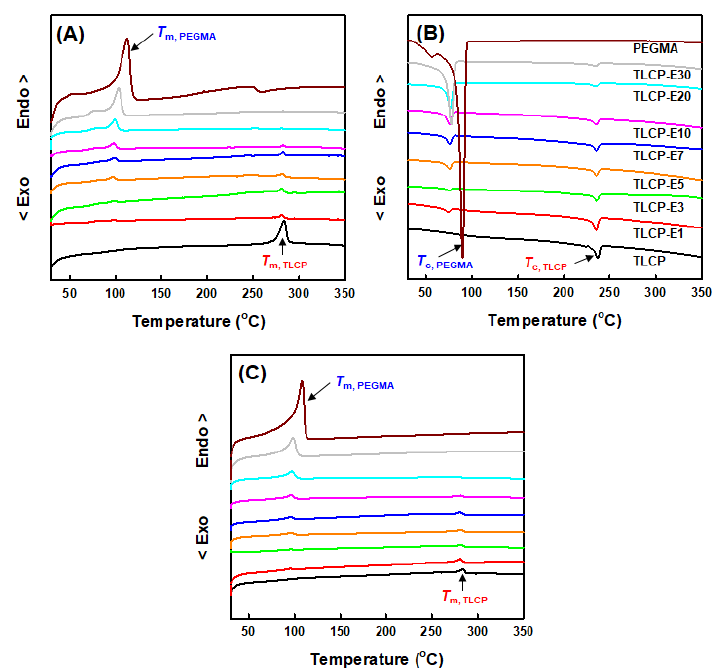
Figure 6. DSC thermograms of neat TLCP, neat PEGMA, and TLCP / PEGMA blends: ( A ) First heating; ( B ) first cooling; ( C ) second heating.